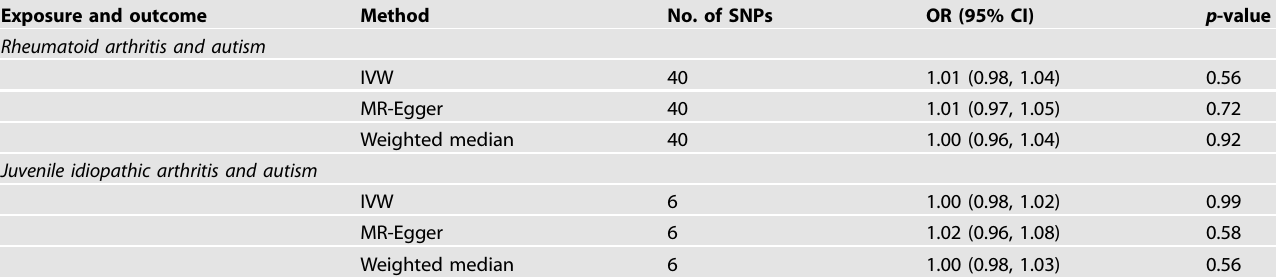
Table 2. MR analysis results assessing causal effects of rheumatoid arthritis on autism, and juvenile idiopathic arthritis on autism. Exposure and